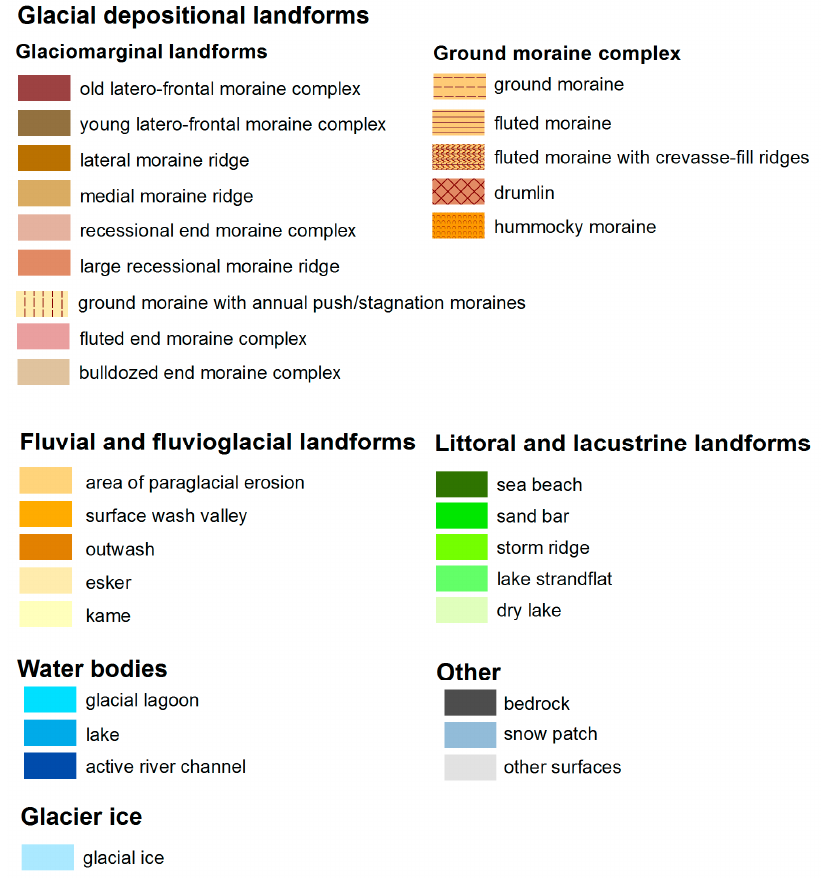
Figure 6. Legend to detailed geomorphological maps in Figures 7, 9 and 10.